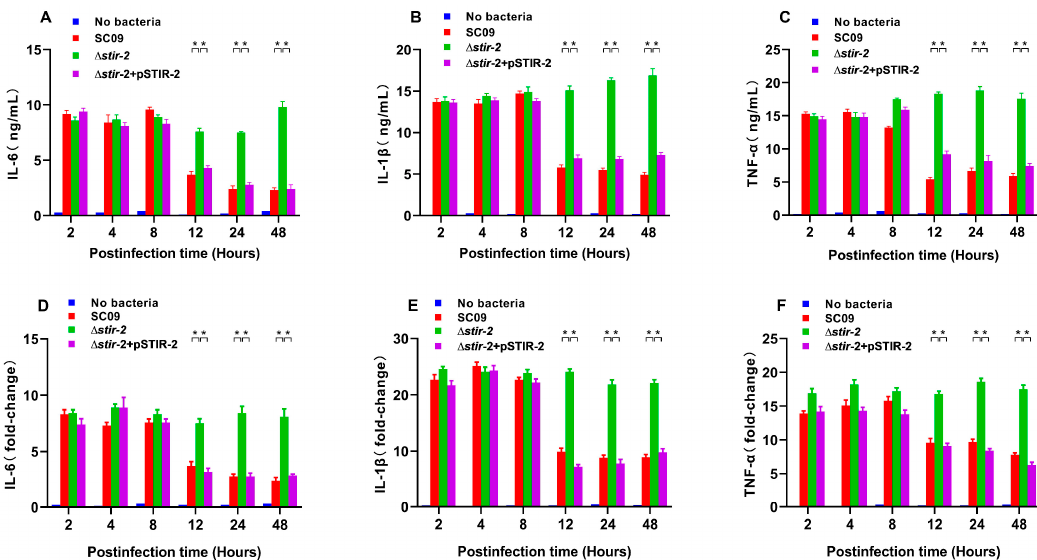
Figure 4. STIR ‐ 2 reduces cytokine secretion and expression in macrophages cells. ( A – C ) IL ‐ 6, IL ‐ 1 β , and TNF ‐α secretion in rainbow trout head kidney macrophages either uninfected or infected with the wild ‐ type Y. ruckeri SC09 strain, Y. ruckeri SC09 Δ stir ‐ 2 mutant, or ∆ stir ‐ 2 + pSTIR ‐ 2 mutant analyzed by ELISA. Cytokine levels were determined at 2, 4, 8, 12, 24, and 48 h after infection. ( D – F ) Expression of IL ‐ 6, IL ‐ 1 β , and TNF ‐α in macrophages either uninfected or infected with the wild ‐ type Y. ruckeri SC09 strain, Y. ruckeri SC09 Δ stir ‐ 2 mutant, or ∆ stir ‐ 2 + pSTIR ‐ 2 mutant was determined by qPCR. Cytokine expression levels were determined at 2, 4, 8, 12, 24, and 48 h after infection. Error bars indicate the standard deviation of six individual cultures. ** p < 0.01, ANOVA on ranks.